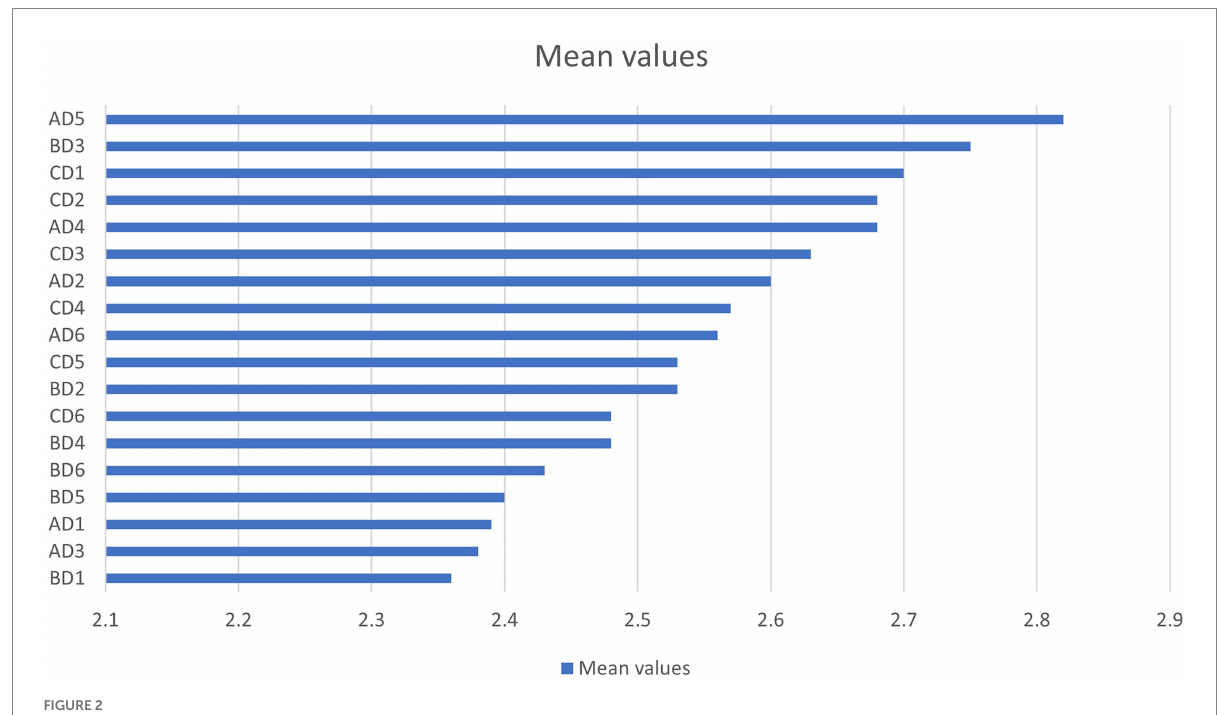
FIGURE 2 Mean values of all items in the three